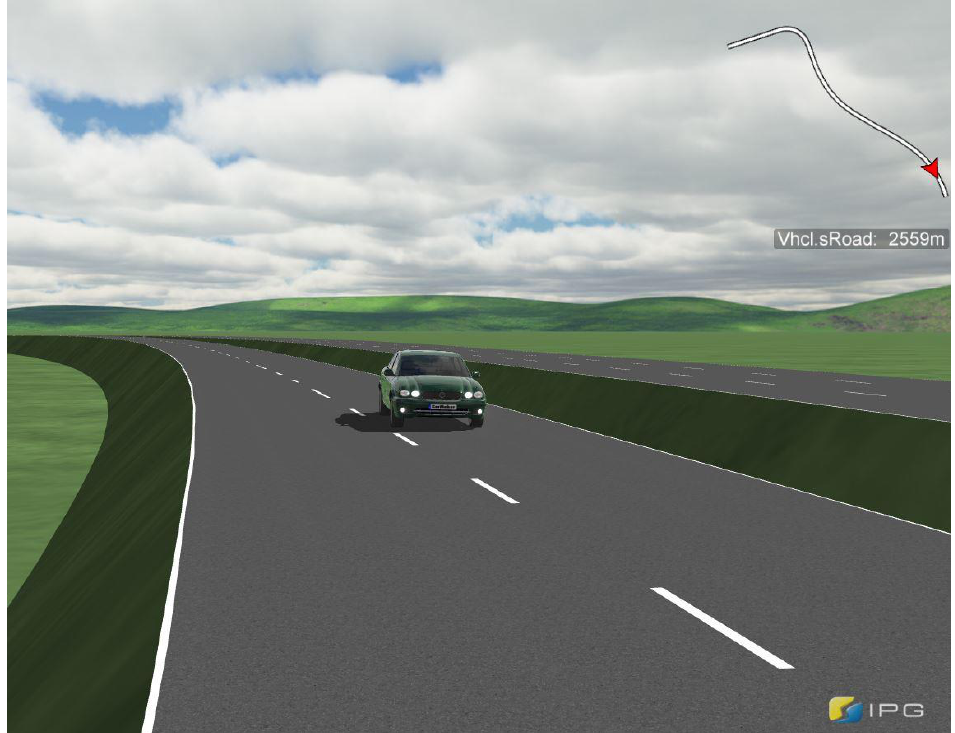
Figure 6. The finished model during